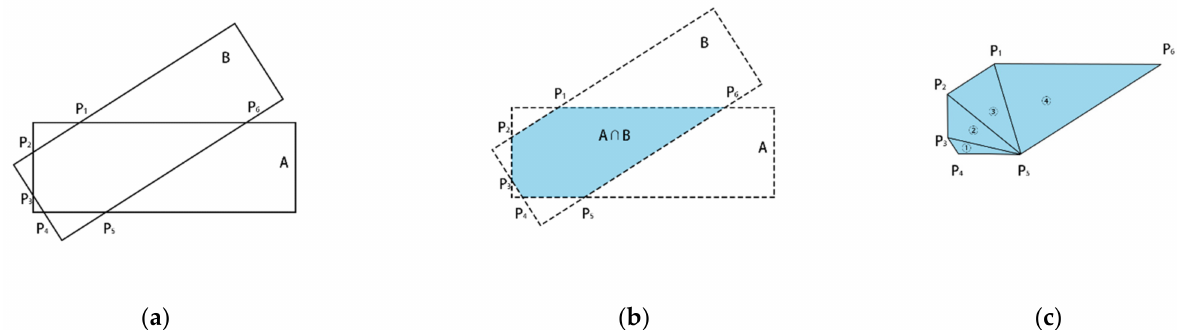
Figure 7. Calculation of S A ∩ B : ( a ) the intersection area of two rotated boxes A and B; ( b ) calculation convex hull (P1, ... , Pn); ( c ) division of the convex